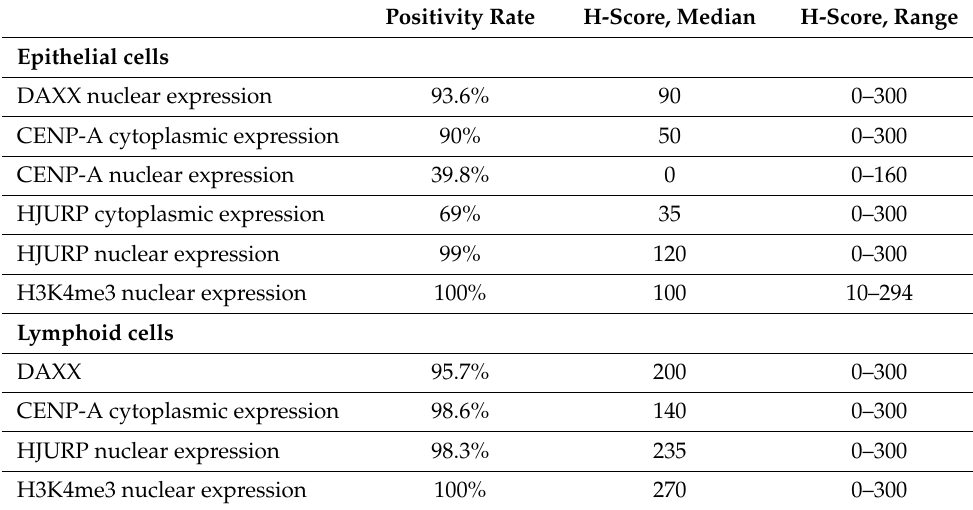
Table 1. Expression of DAXX, CENP-A and HJURP in